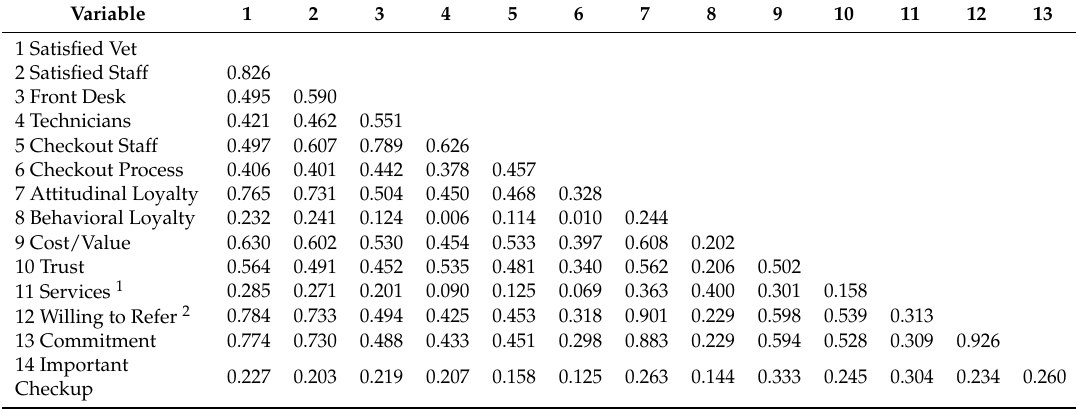
Table 2. Spearman correlation: satisfaction with